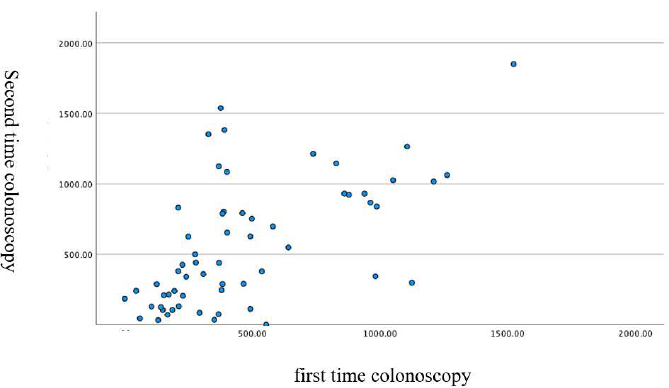
Figure 6. Correlation of the time taken from the splenic flexure to the cecum in the first and the second colonoscopies (scatter plot). Pearson correlation coefficient: 0.608. p < 0.001 two-sided test. According to the UPD images, the patterns for passing through the SDJ were as fol- lows: (1) straight (first colonoscopy, 12; second colonoscopy, 12), (2) N-loop (first colonos- copy, 35; second colonoscopy, 35), (3) α-loop (first colonoscopy, 9; second colonoscopy, 10), (4) reverse α-loop (first colonoscopy, 4; second colonoscopy, 4) and (5) other (first colonoscopy, 1; second colonoscopy, 0). Significant correlation was observed between the methods used in the first and second colonoscopies, as shown in Table 1 (Chi-squared test, p < 0.001 two-sided test).